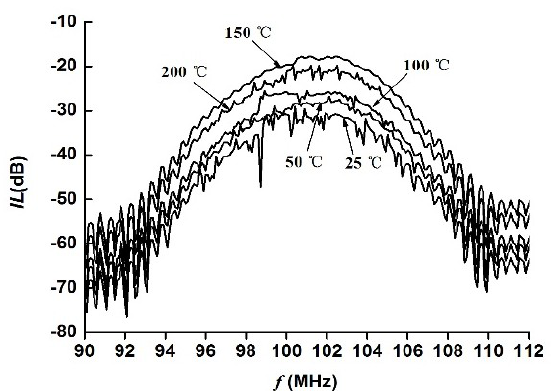
Figure 7. Response characteristics of the Love wave device.